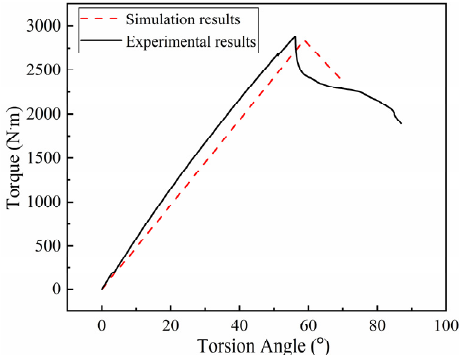
Figure 18. Torque–torsion angle response for the RTP.